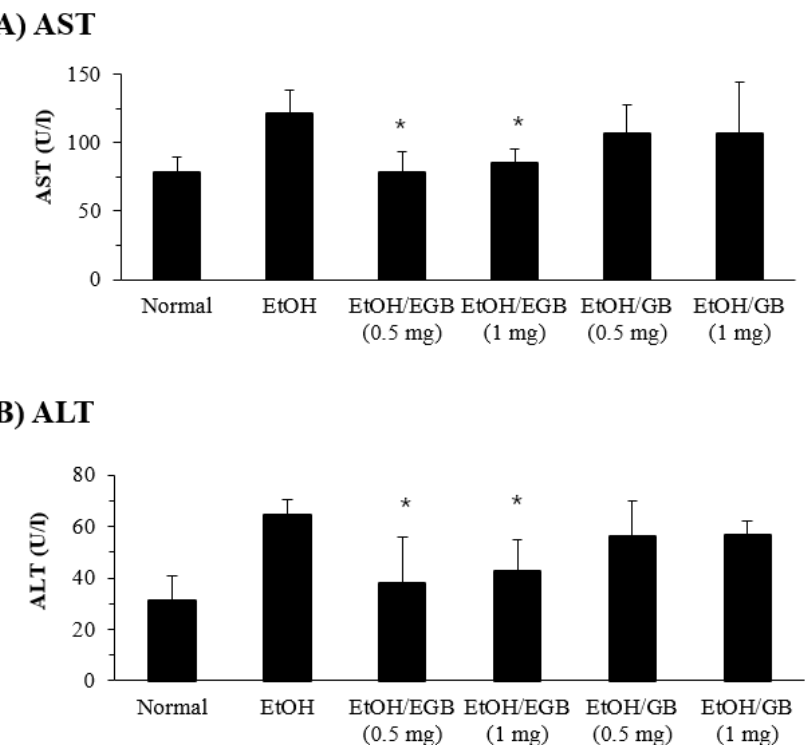
Figure 3. Effect of EGB on serum aspartate aminotransferase (AST) and alanine aminotransferase (ALT) in alcohol-induced liver damage (AILD). The AST ( A ) and ALT ( B ) levels were measured using serum specimens collected 1 day after the final administration of EtOH. * p < 0.05, compared with the EtOH-fed group.